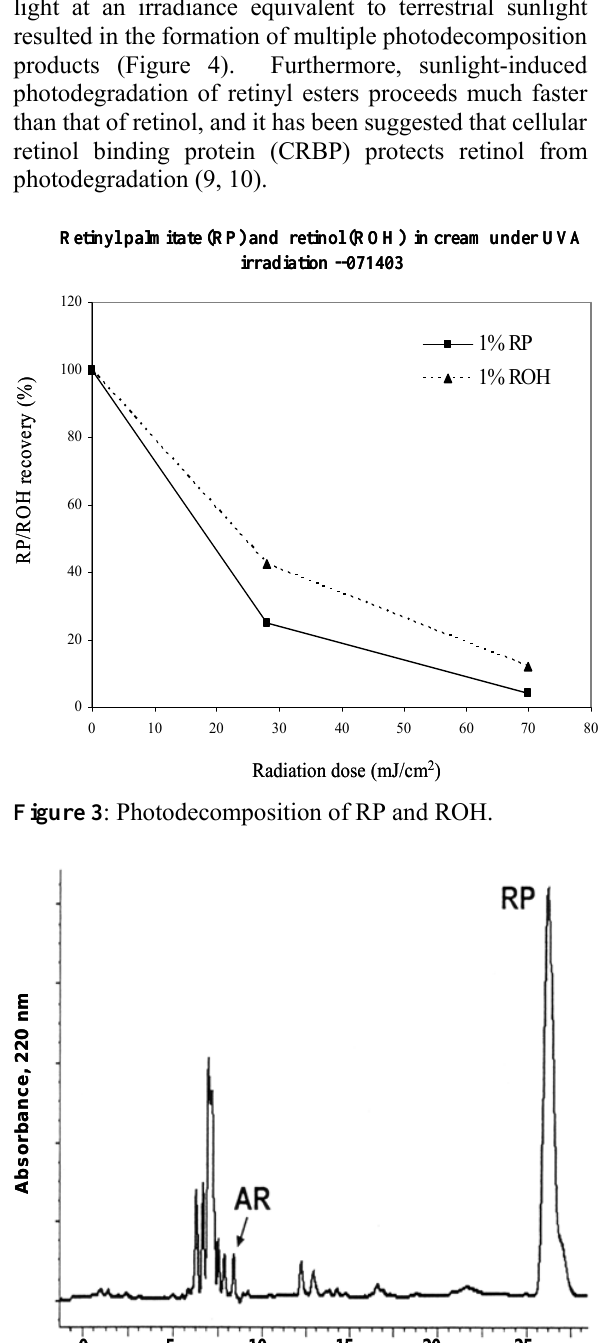
Figure 2: Decomposition of 2% RP in oil-in-water cream at 4 ο C.